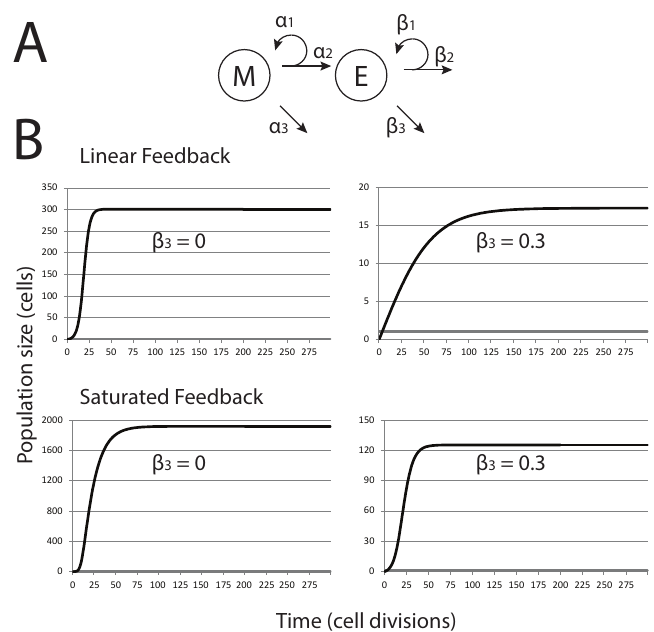
(senescence of E 3